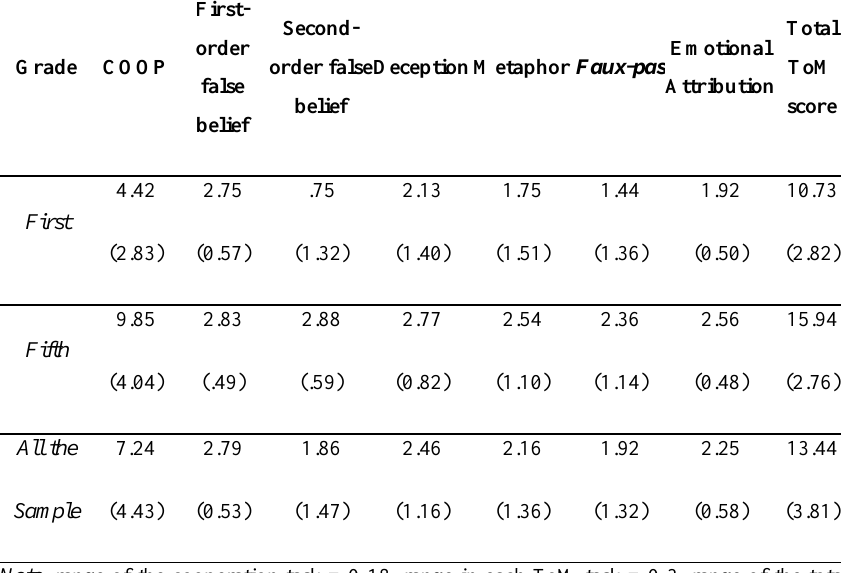
Mean (and standard deviation) in the cooperation and ToM tasks in the total sample and as a function of